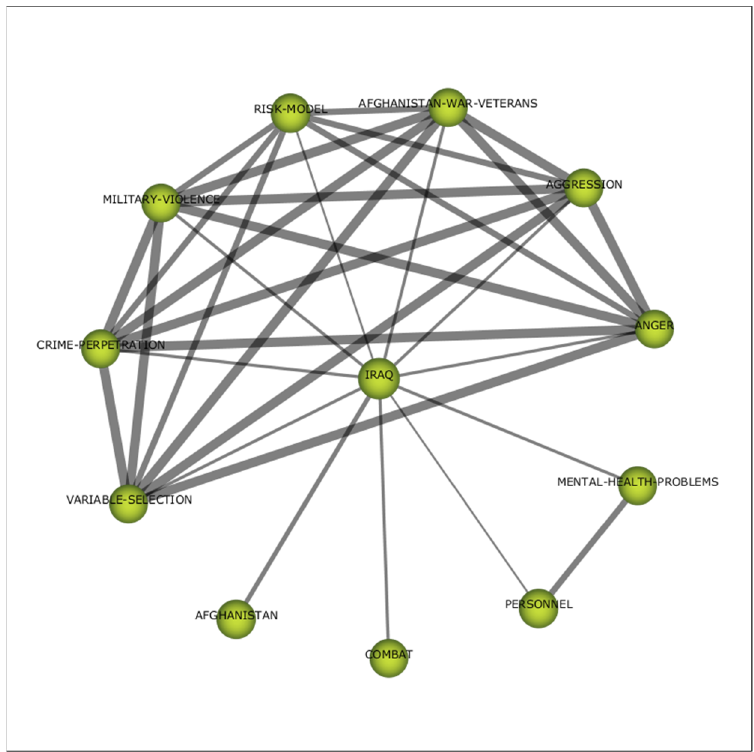
Figure 10. Category: Psychological and behavioral disorders; From 2016; Theme: Iraq and Afghanistan wars.